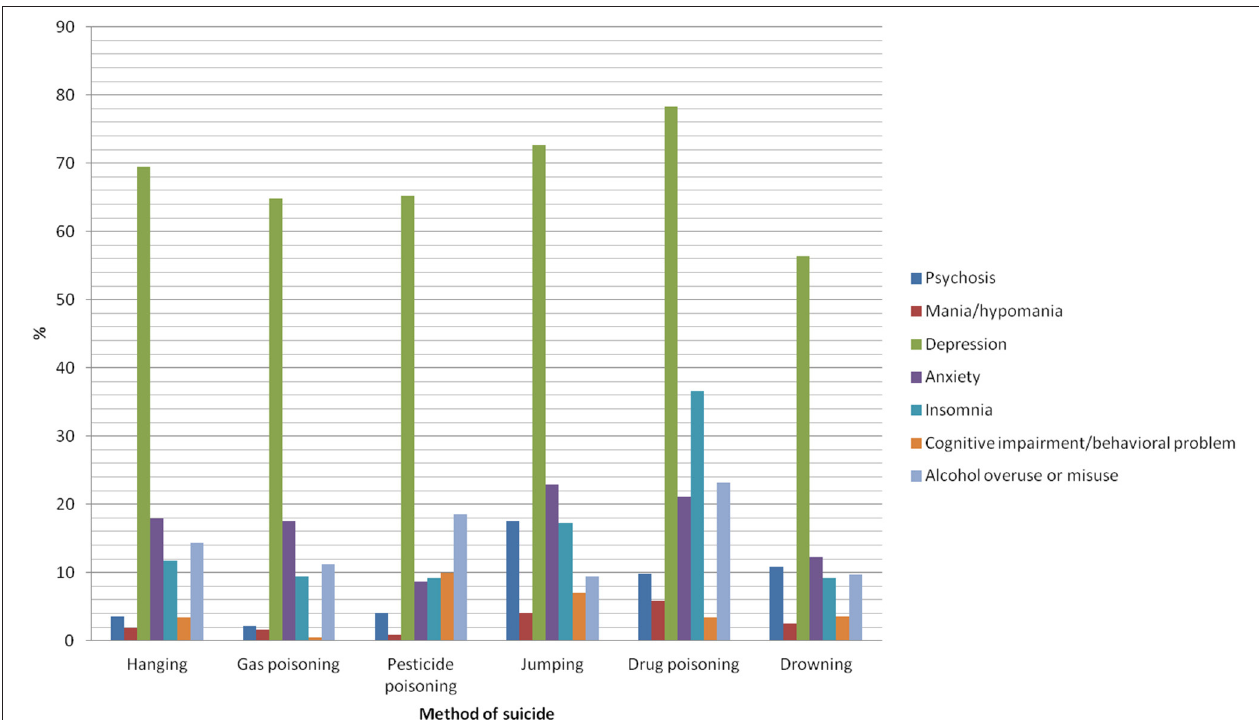
FIGURE 1 | Manifestation of psychiatric symptoms before death by suicide according to suicide